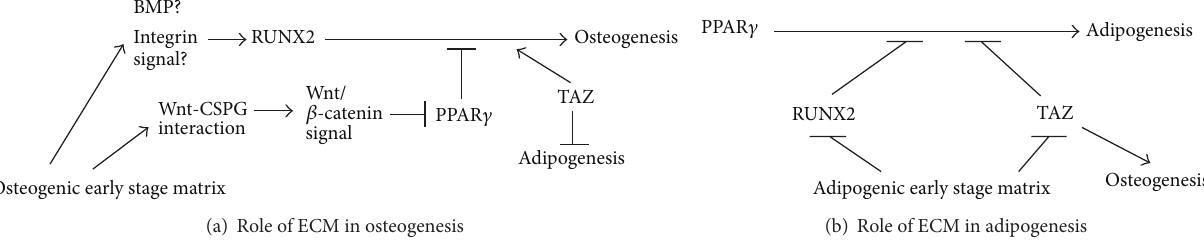
Figure 3: MSC differentiation mechanism on tissue development-mimicking matrices. (a) Role of tissue- and stage-specific ECM in the osteogenesis of MSCs. (b) Role of tissue- and stage-specific ECM in the adipogenesis of MSCs.